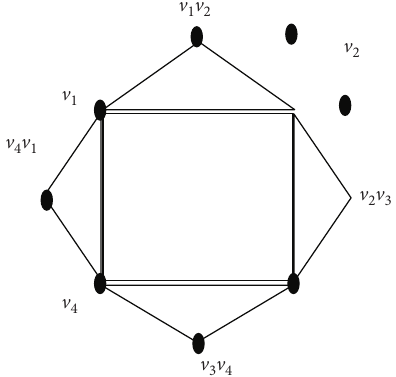
Figure 4: 2-Quasitotal fuzzy graph of G